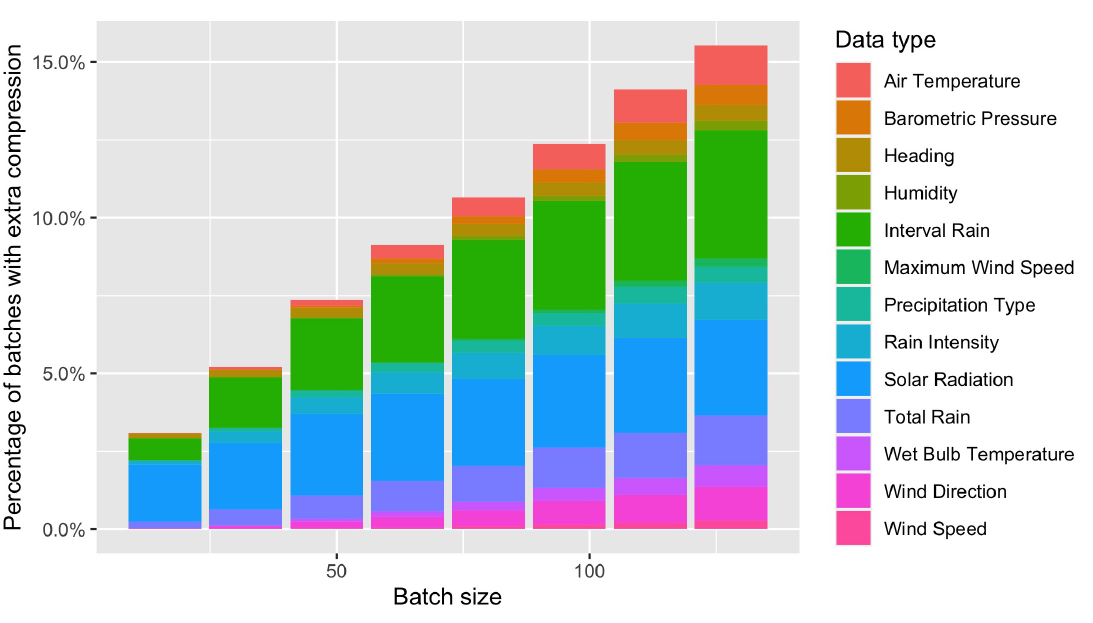
Figure 10. Number of cases where multi-parameter Rice coding yields shorter codes than the single-parameter Rice coding